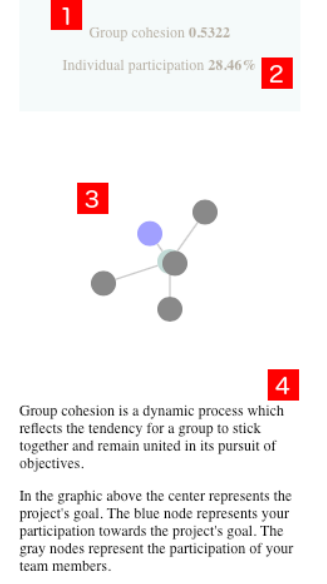
Figure 2. Cohesion-based feedback